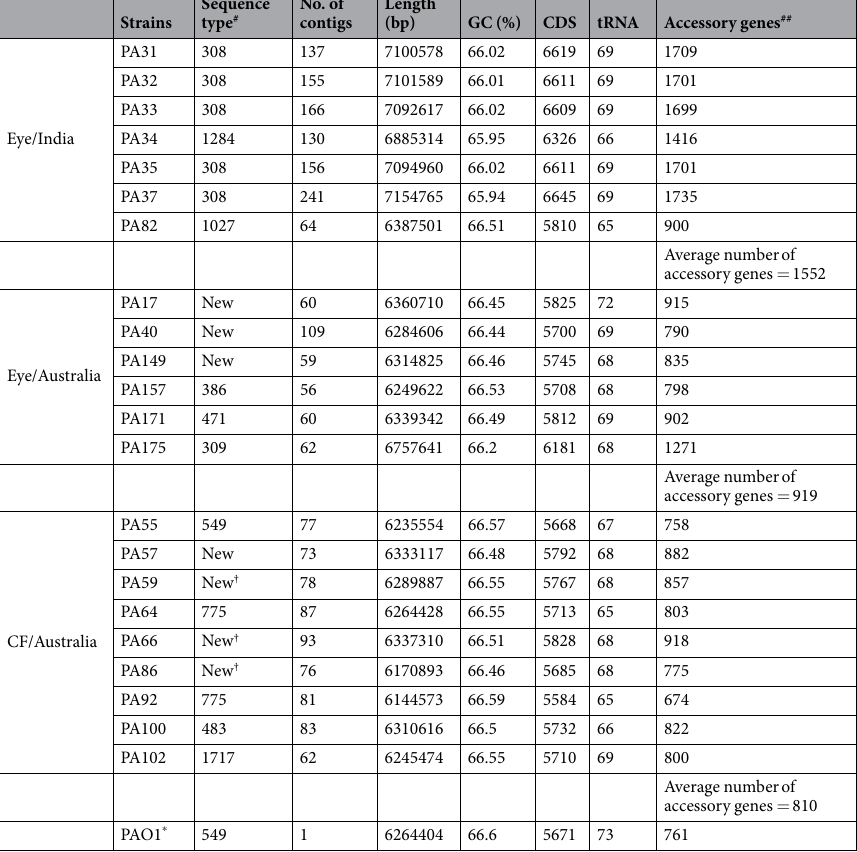
Table 1. General features of the genomes of P . aeruginosa strains. # Sequence types were determined by the multi locus sequence typing database. The sequence types not listed in the MLST database have been deemed as new. ## Accessory genes were determined by subtracting number of core genes (4910) from total number of CDS. † Same MLST allelic profile. * Reference